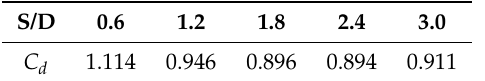
Table 1. C d of a circular cylinder with a passive